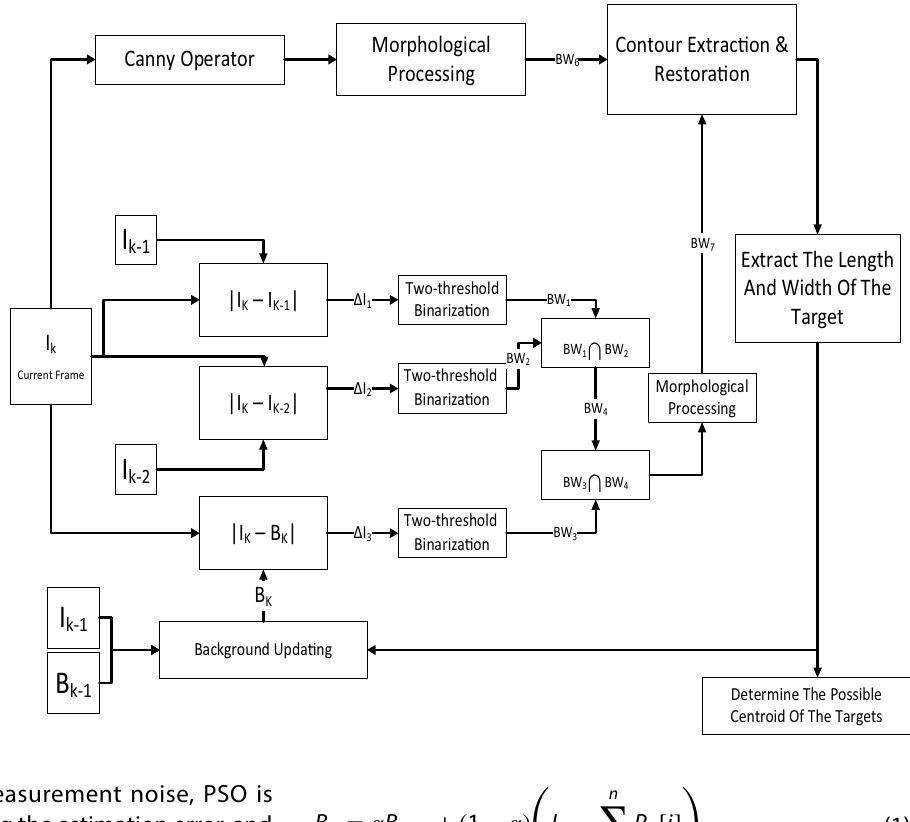
Fig. 2 Procedure of targets detection in the proposed